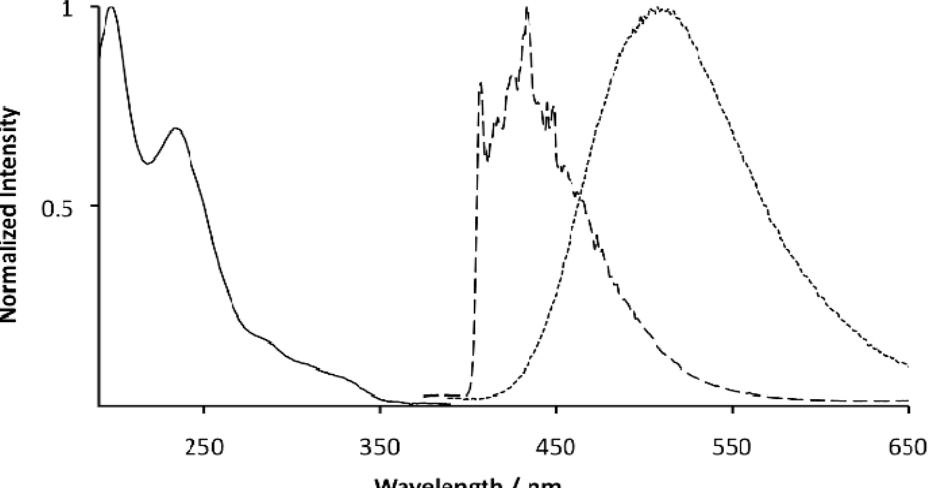
= 335 nm). 77 K emission spectrum exc = 335 exc